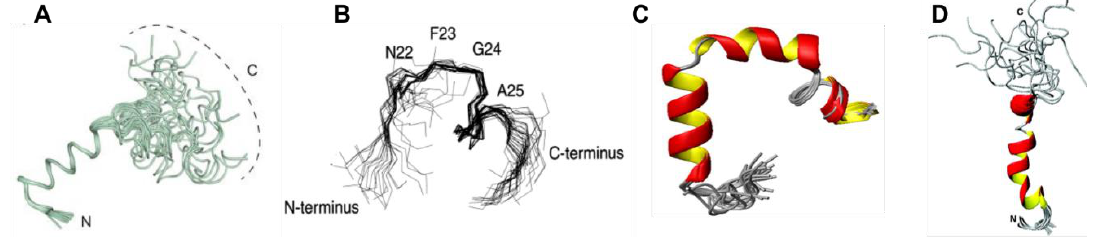
Figure 5. NMR structural ensembles: ( A ) hIAPP oxidised at pH 5.3 and at a temperature of 4 °C (PDB code 5MGQ). Adapted from Rodriguez Camargo et al. [52]. Copyright 2017 Rodriguez Carmargo et al. ( B ) Superposition of the hIAPP backbone Cα atoms for residues 20–29 (PDB code 1KUW). Adapted from Mascioni et al. [53] Copyright (2013) John Wiley and Sons. ( C ) hIAPP in a micelle environment (PDB code 2L86). Adapted from Nanga et al. [54] Copyright (2011) with permission from Elsevier. ( D ) rIAPP in a micelle environment (PDB code 2KJ7). Adapted from Nanga et al. [55]. Copyright